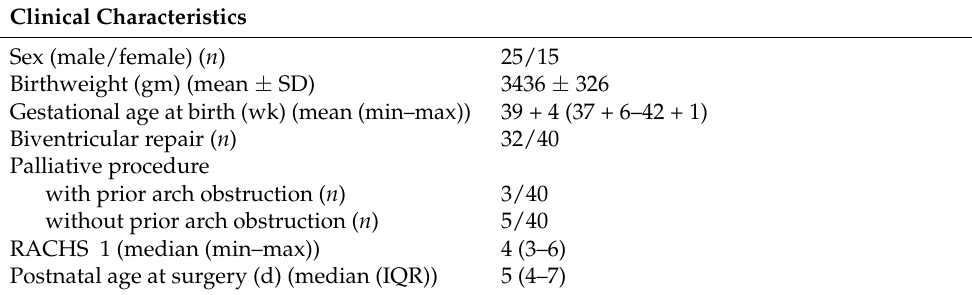
Table 1. Clinical characteristics of included study participants. RACHS = Risk Adjustment for Congenital Heart Surgery, IQR = inter-quartile